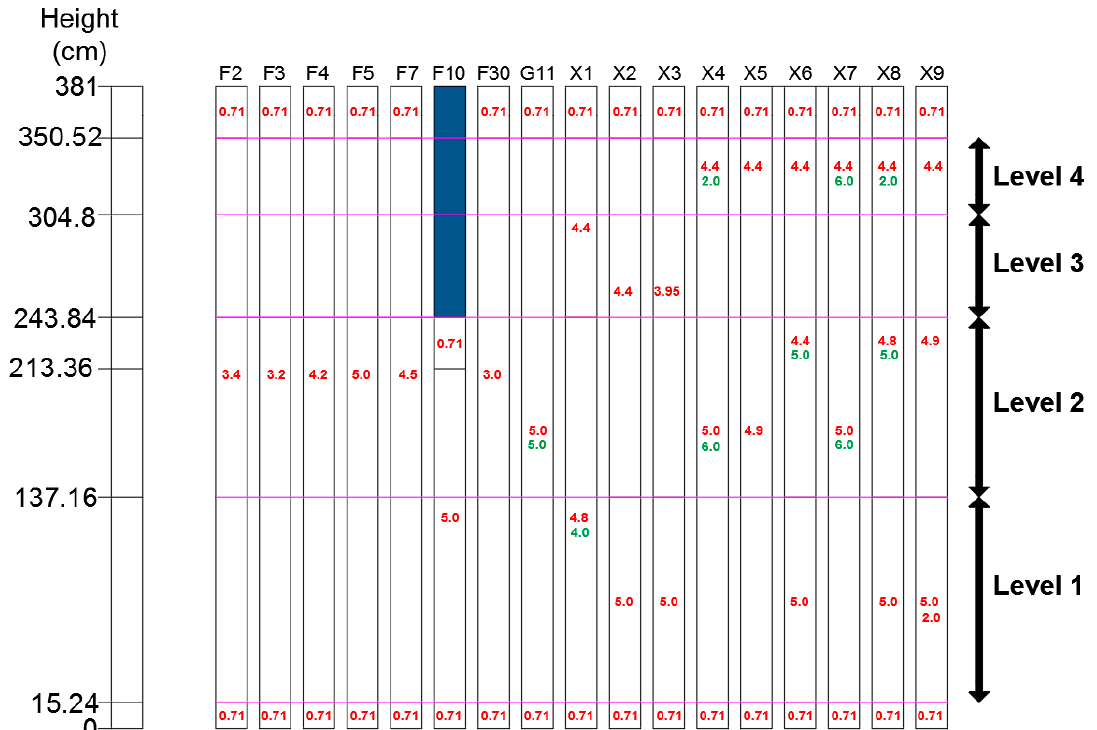
Figure 5. Highlighting the levels of the axial variation of the fuel assemblies used for the cross-section preparation. The axial variations in BWRs are used to control the axial power profile.